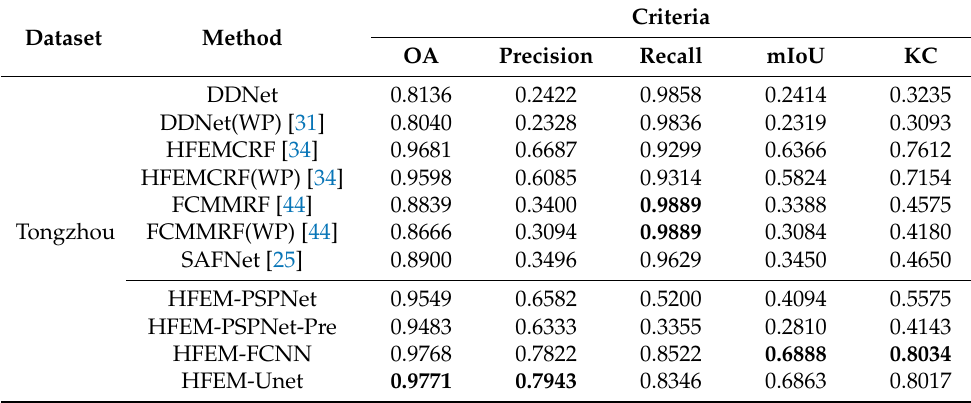
Table 4. The numerical results of Tongzhou